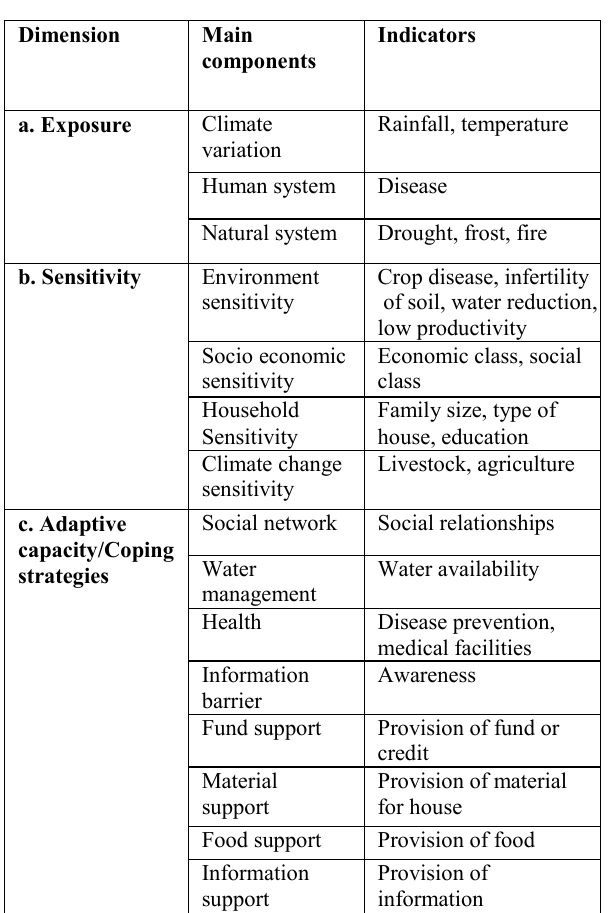
Table 3. Range wise and village wise Vulnerability